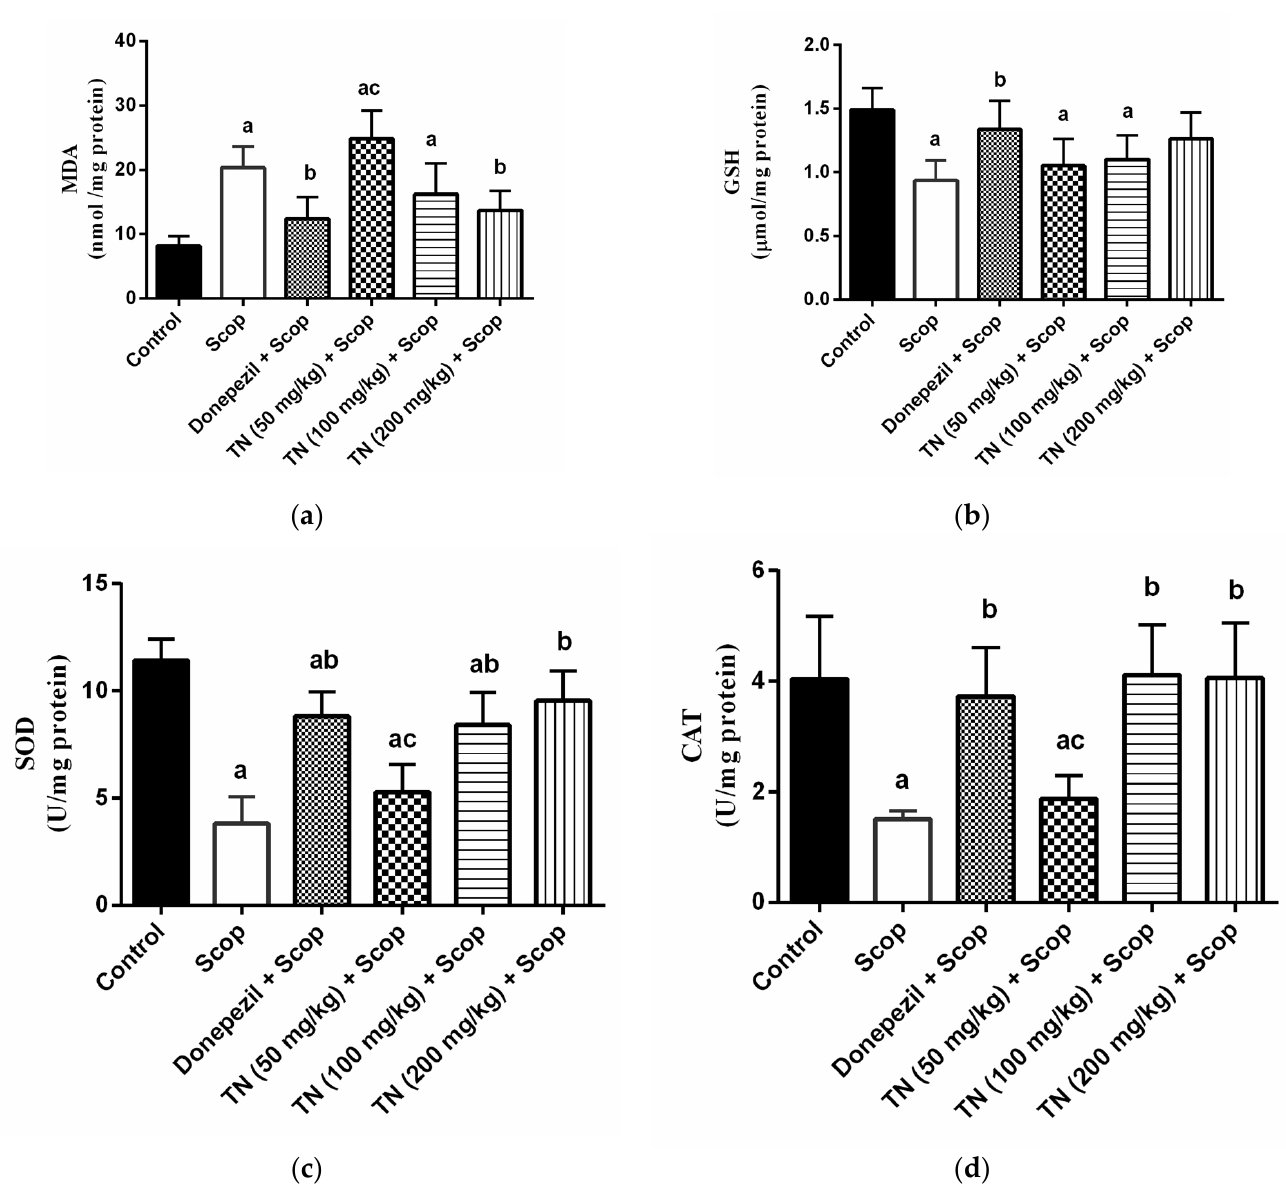
Figure 4. Effect of different doses of tiger nut on Scop-induced oxidative stress. ( a ) MDA, ( b ) GSH, ( c ) SOD and ( d ) CAT. Values are expressed as the mean ± SD ( n = 6). Values are statistically significant at p < 0.05 versus the control group, p < 0.05 versus the Scop-treated group and p < 0.05 versus donepezil-treated group.